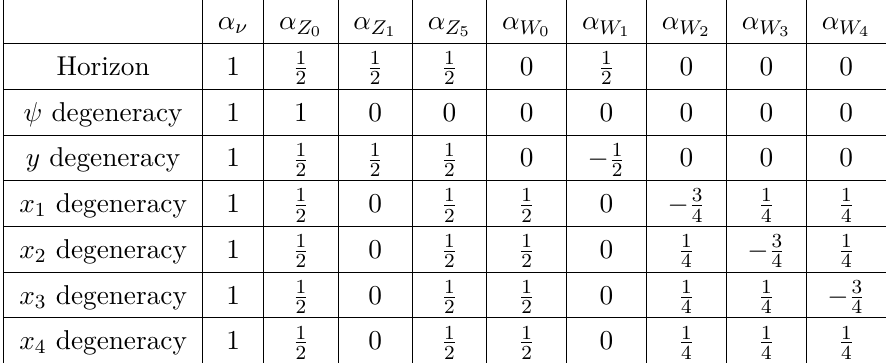
Table 3 . The seven choices of boundary conditions at a rod source (2.15) leading to a regular coordinate degeneracy of the timelike direction or a compact spacelike